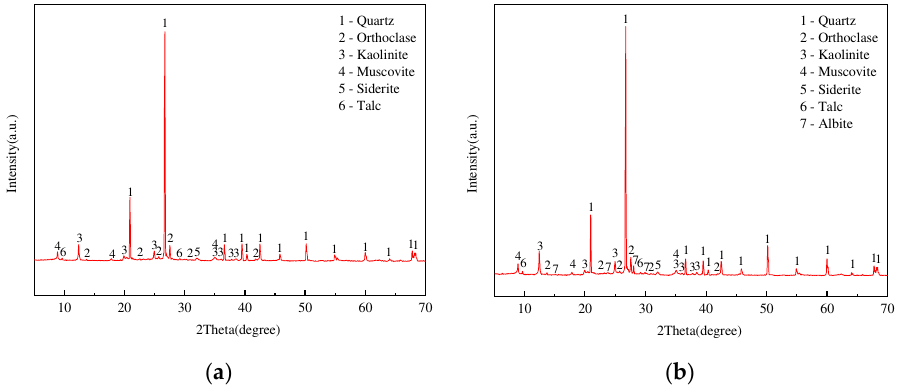
Table 1. Composition of rock components.